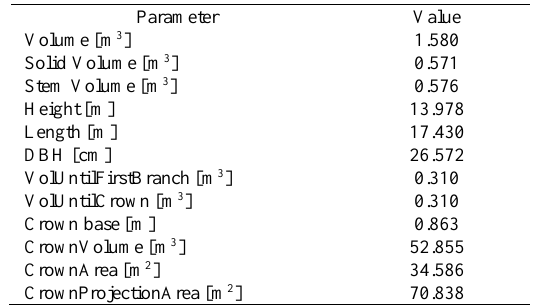
Table 2. Detailed parameter of tree